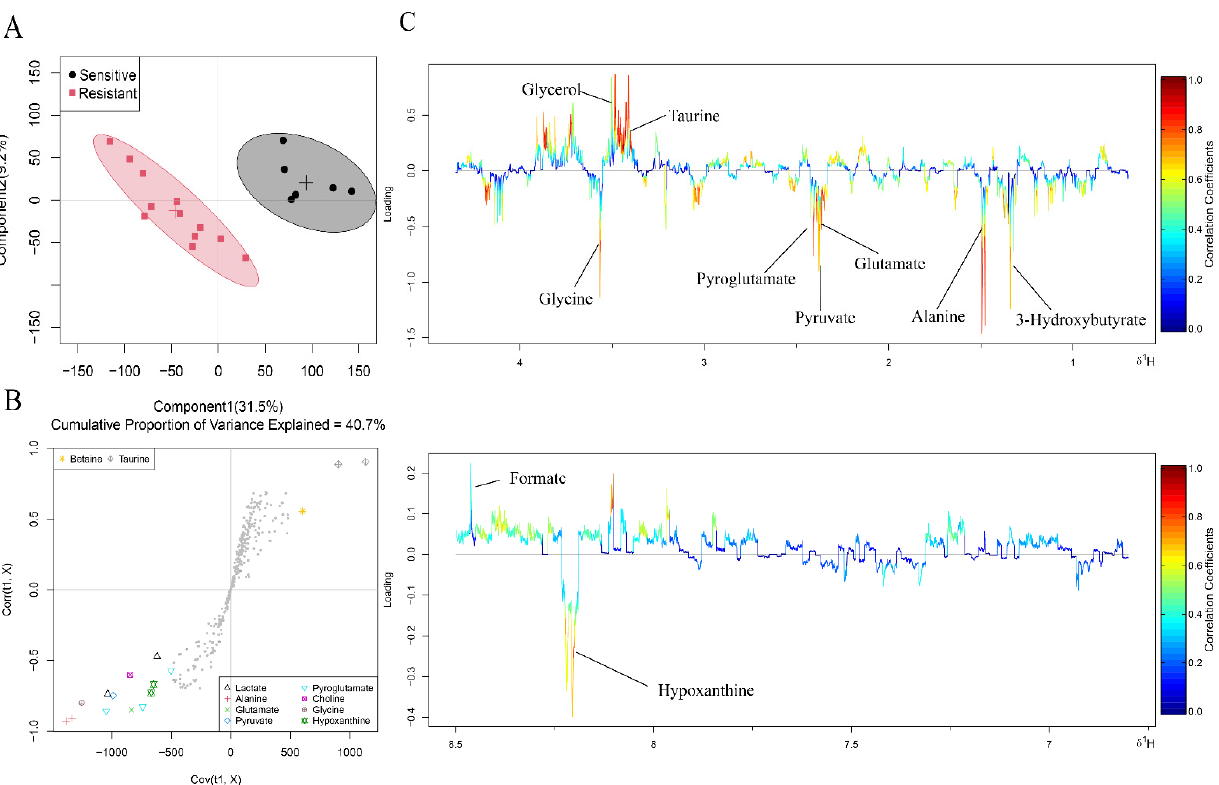
Figure 2. OPLS-DA analysis of the data obtained from 1 H-NMR between the two groups. ( A ) Score plots. Each point is one sample. Different groups are in different colours, with circles representing the 95% confidence interval. ( B ) S plots. Different shapes represent different metabolites. ( C ) Corre- sponding colour-coded loading plots. Colour is encoded by the absolute correlation coefficient of each variable to the grouping, with hot-colour more significant than cool-colour signals.